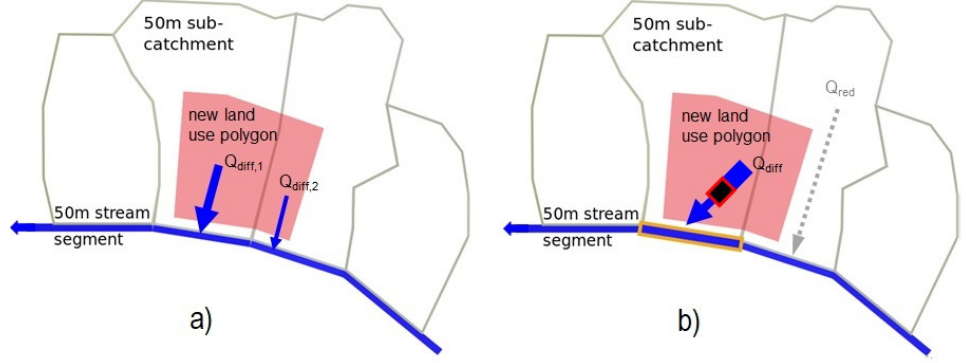
Figure 4. Allocation of the runoff difference to the 50 m-stream segments without ( a ) or with ( b ) definition of a receiving segment (black box with red outline = throttle).